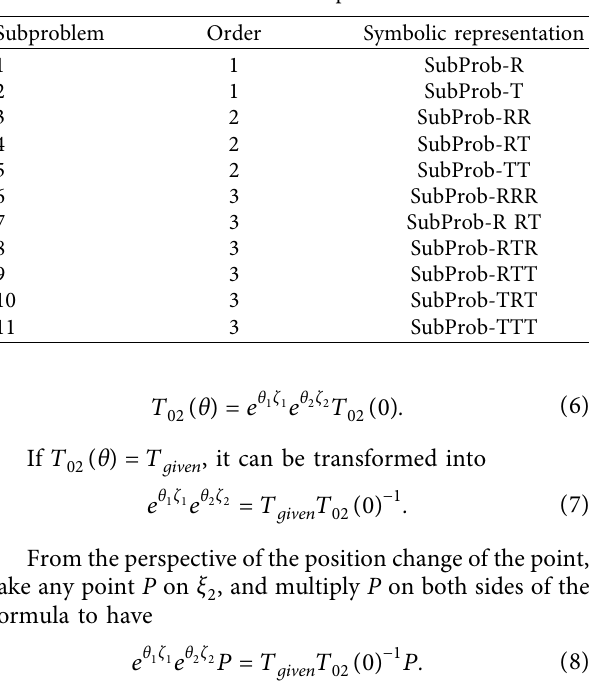
Figure 3: Joint screw modeling method. Table 3: Inverse kinematics subproblem classification.